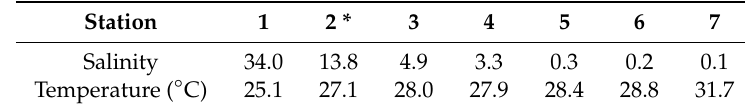
* Indicates the sampling station where Tenellia adspersa was